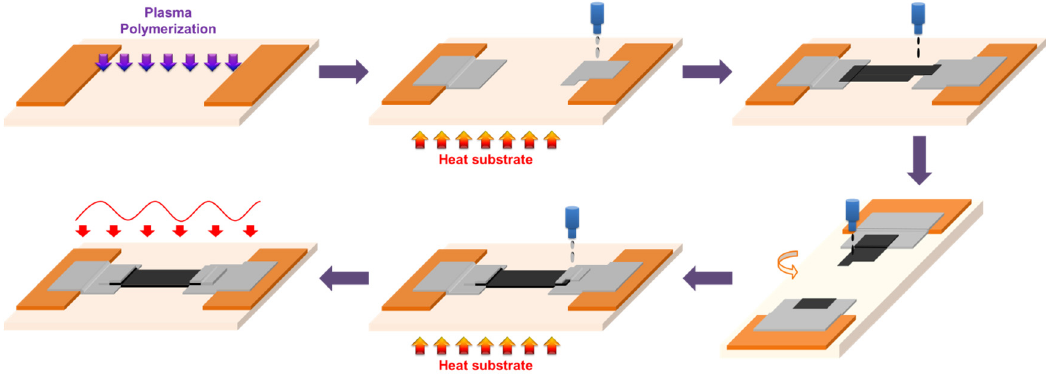
Figure 1. The fabrication of the fully inkjet-printed strain sensor.